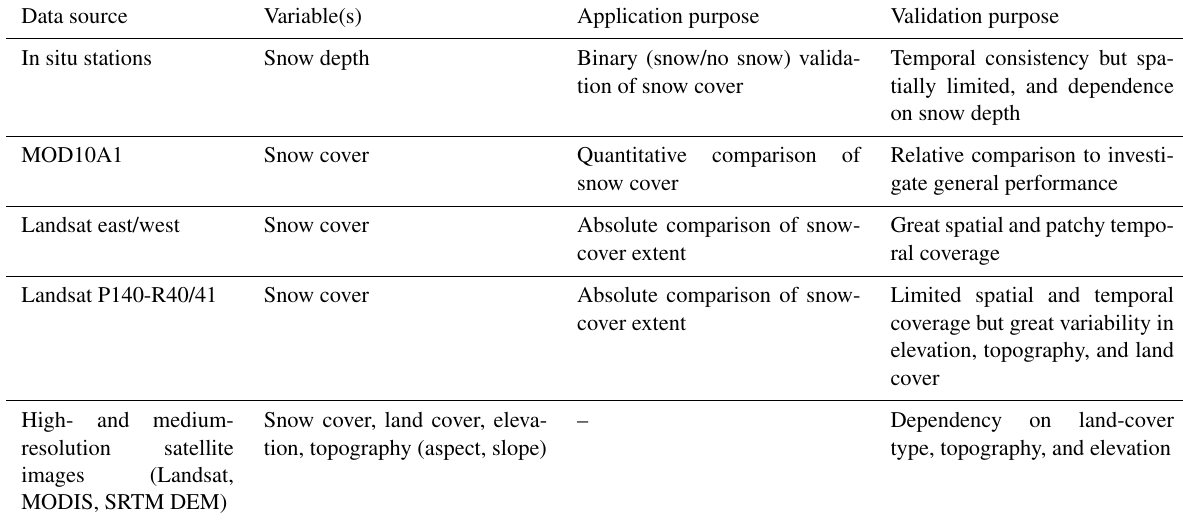
Table 1. Validation strategy: data and